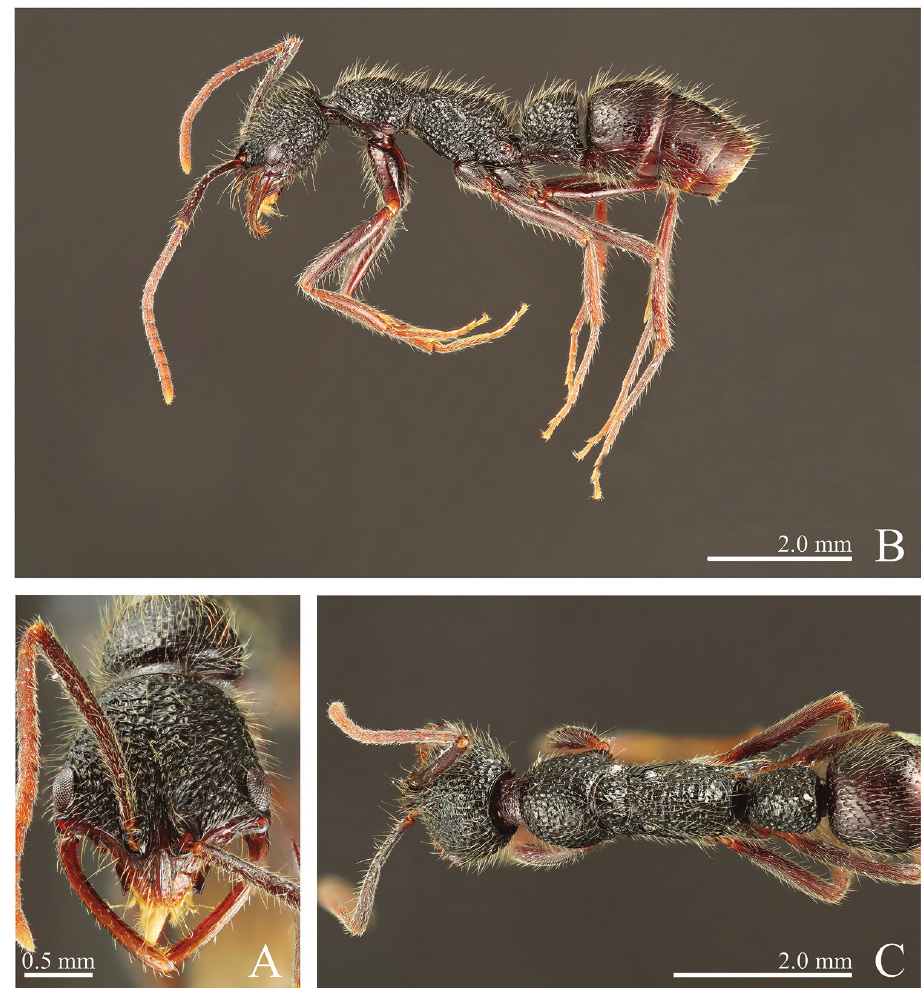
Figure 9. Leptogenys itoi sp. n., paratype, queen; gastral apical two segments removed. A head, full-face view B lateral view C dorsal